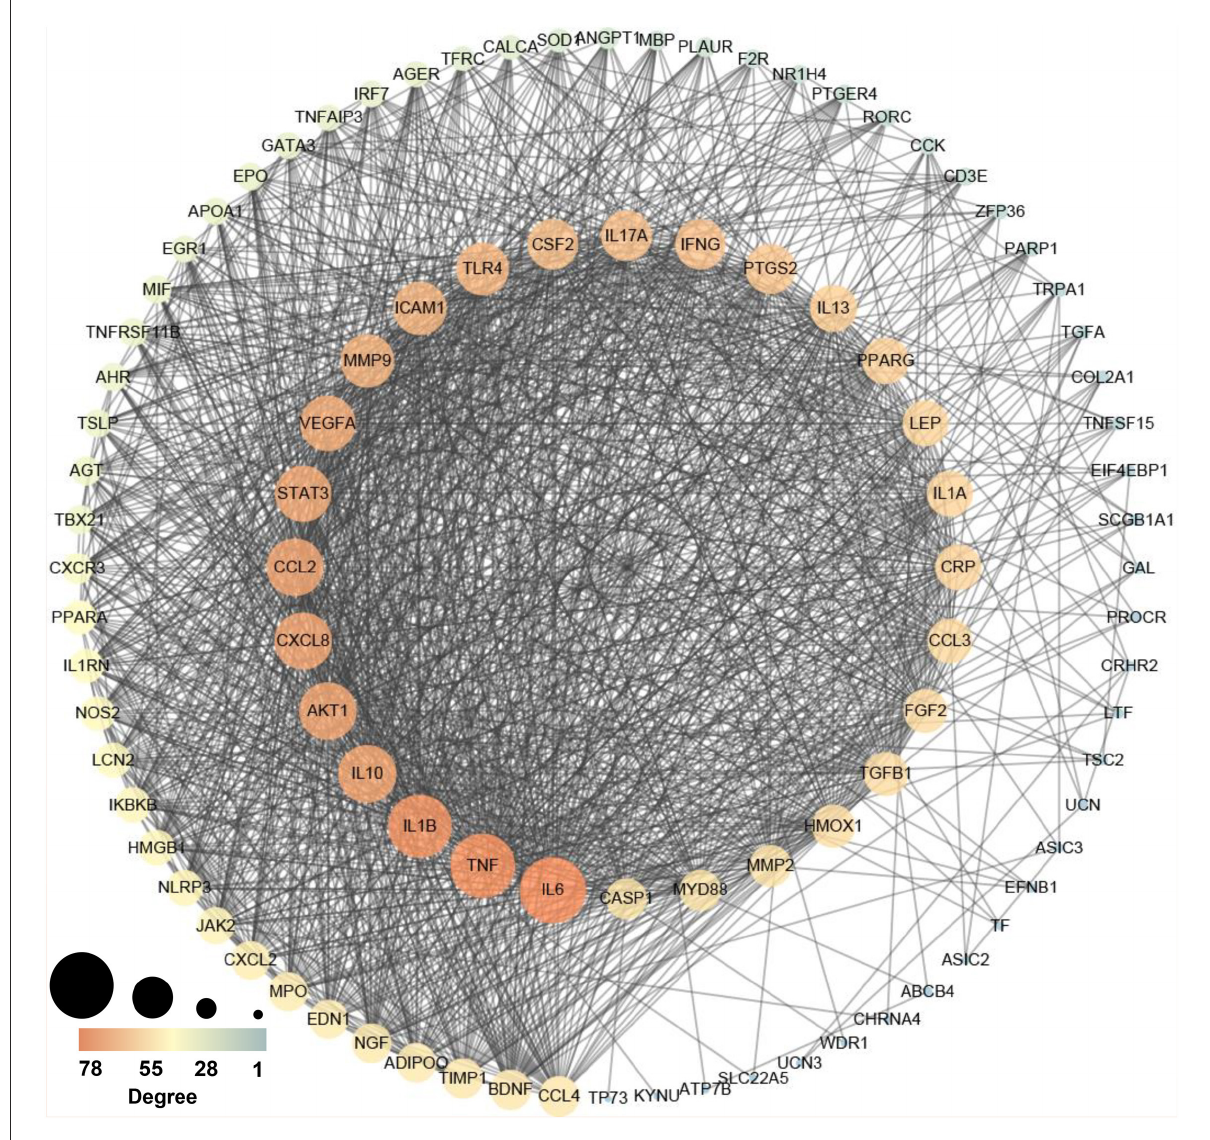
FIGURE5 Protein–protein interaction (PPI) network establishment of the chemicals – inflammation genes (A larger value leads to a larger size, and a larger value leads to an orange